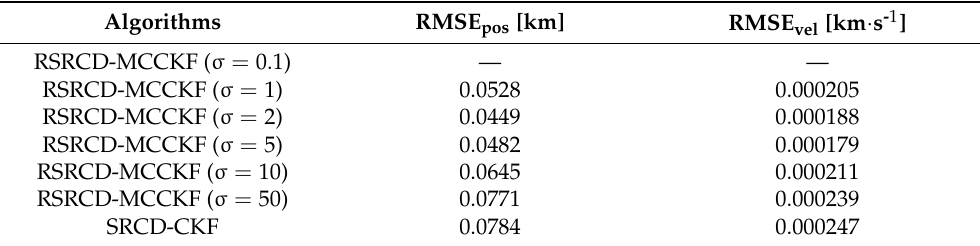
Table 1. Algorithm accuracy under Gaussian noise when kernel bandwidth is different.